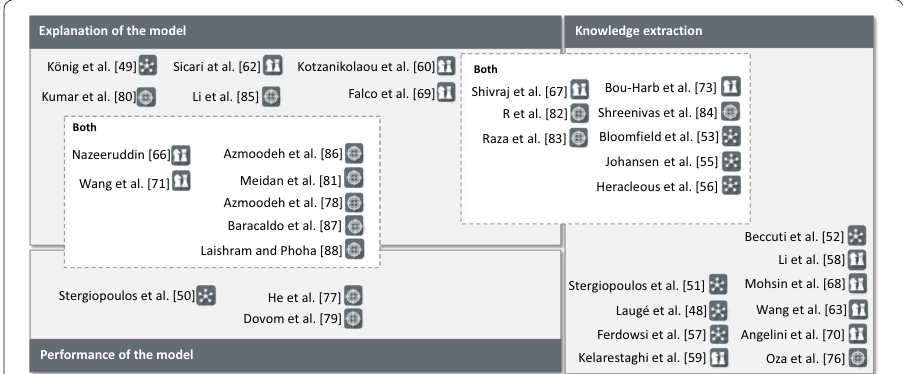
Fig. 9 The distribution of visualization types. The papers that consider two different visualization categories are illustrated close to the line that distinguishes two categories. Labels: —employed for dependency